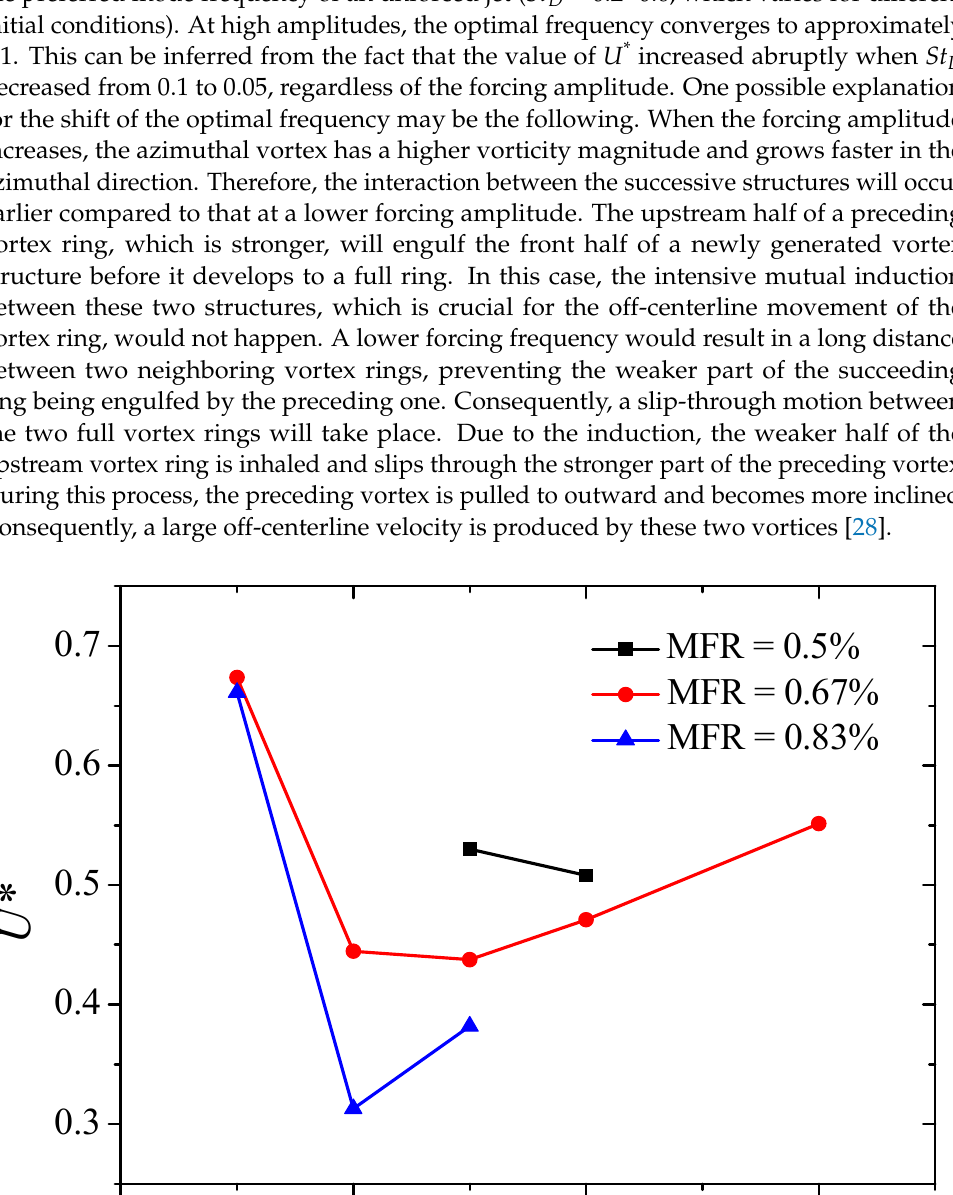
( d ) Figure 22. Coherent structures under different amplitudes and frequencies, visualized by the iso- surface of pressure and colored by the streamwise velocity magnitude, p / ρ U j 2 = − 0.05. ( a ) MFR = 0.67%, St D = 0.15, ( b ) MFR = 0.67%, St D = 0.2, ( c ) MFR = 0.83%, St D = 0.1, ( d ) MFR = 0.83%, St D = 0.15.